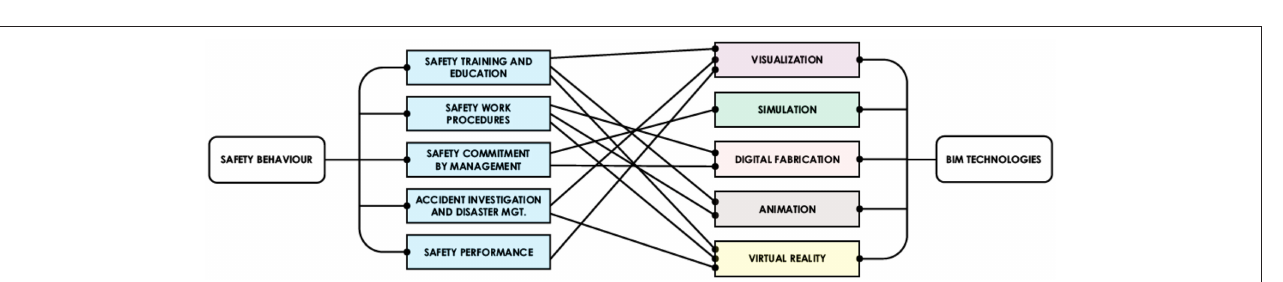
occur between BIM technologies and the components of the dimensions of construction safety culture. Hence, the model was therefore considered validated based on the criteria of Grounded